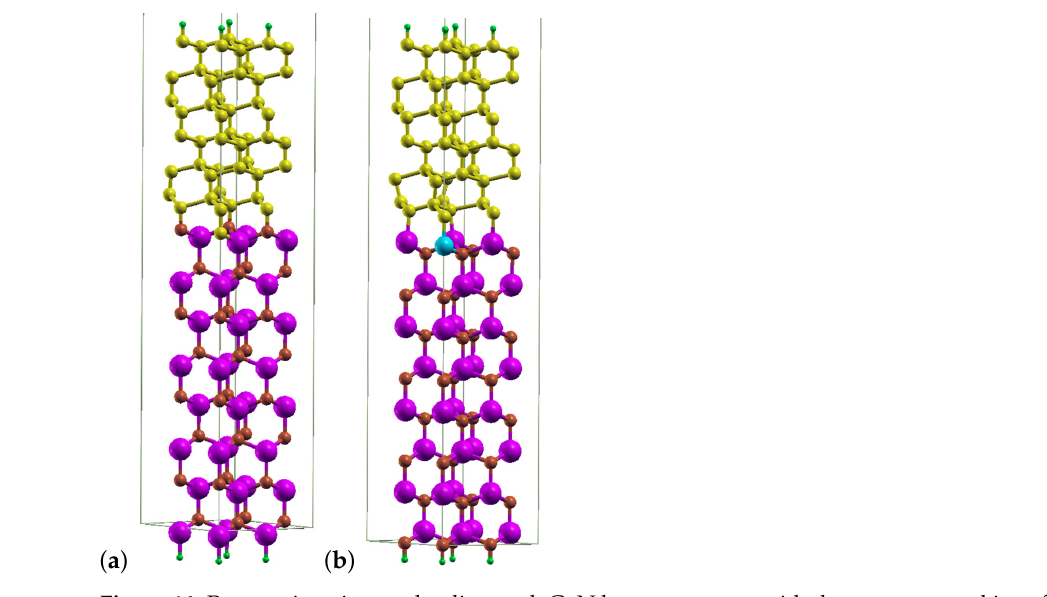
Figure 14. Perspective view at the diamond–GaN heterostructure with the reconstructed interface according to the pattern ( a ) 3 N + 1 C N and ( b ) 3 Ga + 1 Si Ga . The large blue ball represents the Si atom.